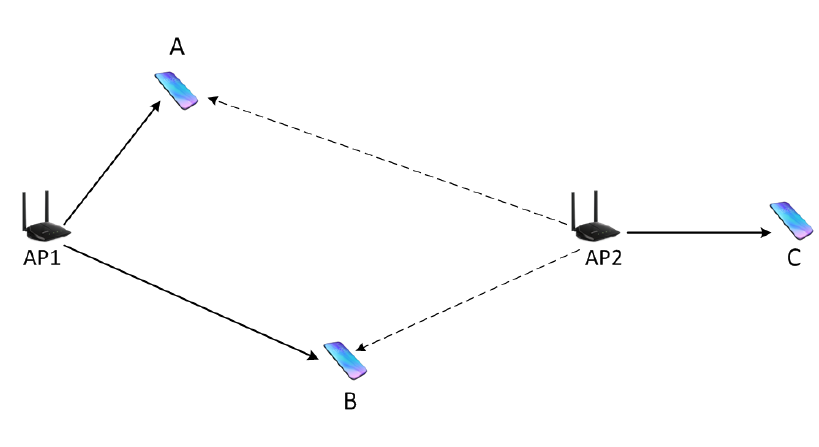
Figure 1. An example network scenario. AP2 can transmit to node C if AP1 is transmitting to node A, but should defer its transmission if AP1 is transmitting to node